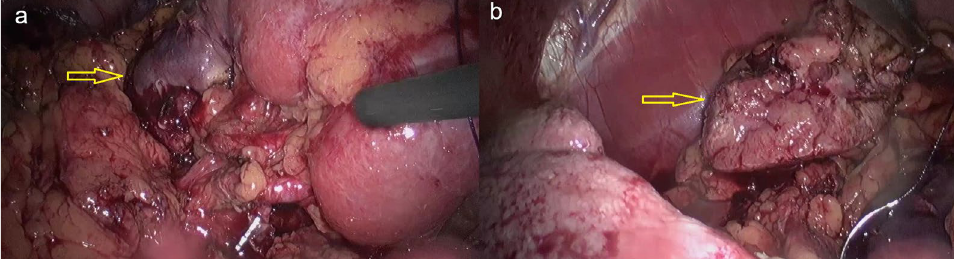
Fig. 7 a Appearance of the kidney after renorrhaphy and final satinsky unclamping. Mild bluish discoloration is noticed at the upper pole (marked with yellow arrow). b Excised partial nephrectomy specimen (marked with yellow